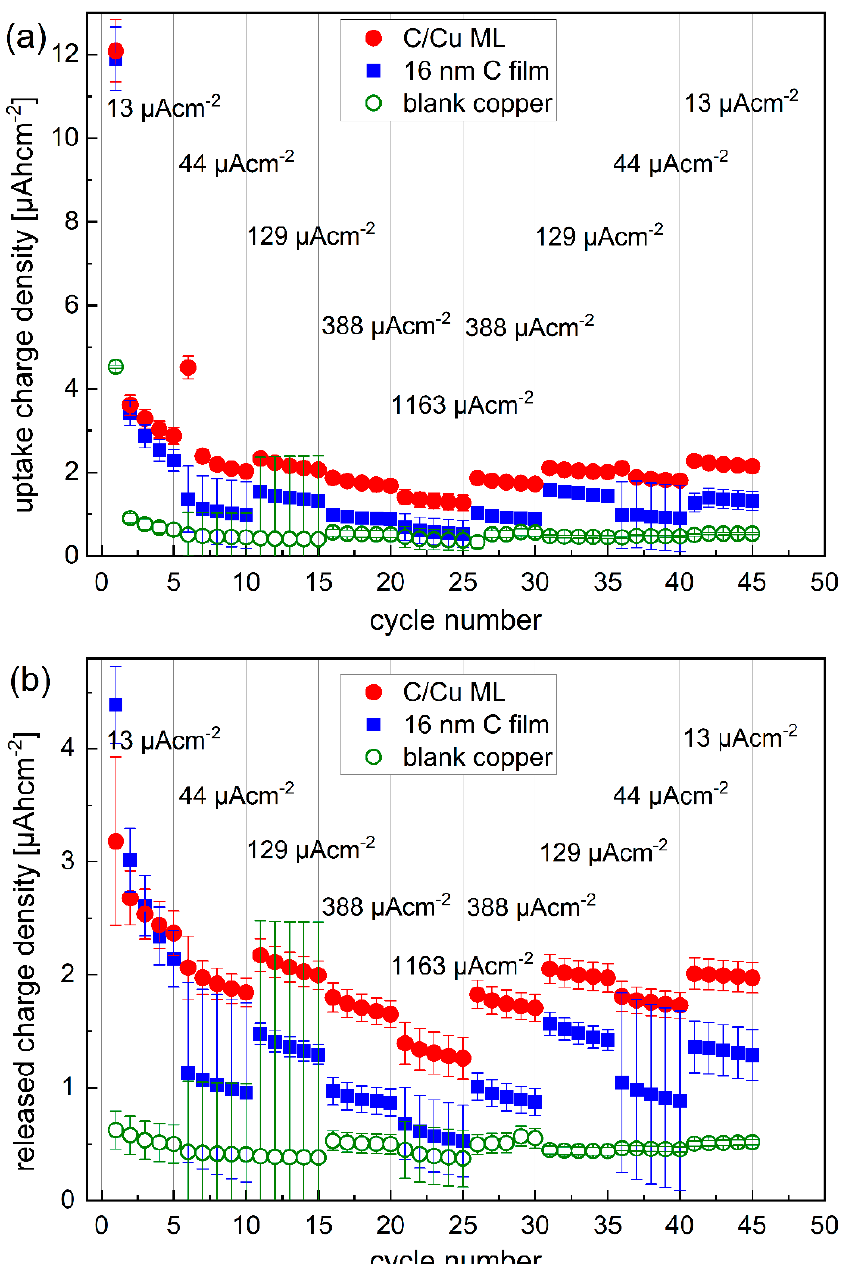
Figure 3. Inserted ( a ) and released ( b ) Li + charge density into and from the C/Cu ML electrode (red dots), respectively, compared to that of the 16 nm carbon film (blue squares) and to the electrode without carbon (green open circles). After each packet of five cycles (marked with thin vertical gray lines), the current density was stepwise increased from 13 to 1163 µ Acm − 2 and subsequently stepwise decreased to 13 µ Acm − 2 . A color version of this figure can be viewed online. Figure 4a presents a variation of the gravimetric capacity for Li + uptake and release of the electrode of a C/Cu ML with the cycle number. The right y -axis is the normalized capacity by the maximal capacity of graphite. The Coulombic efficiencies (CEs, Figure 4b) obtained from the C/Cu ML (filled squares) are similar to that of the blank copper (unfilled green circles). The CE is more than 90% after the 10th cycle, revealing a good reversible Li + insertion. At high current densities, large rates of up to 937C (Figure 4) appear, which means that full lithiation is reached in less than 4 s. The results from the test